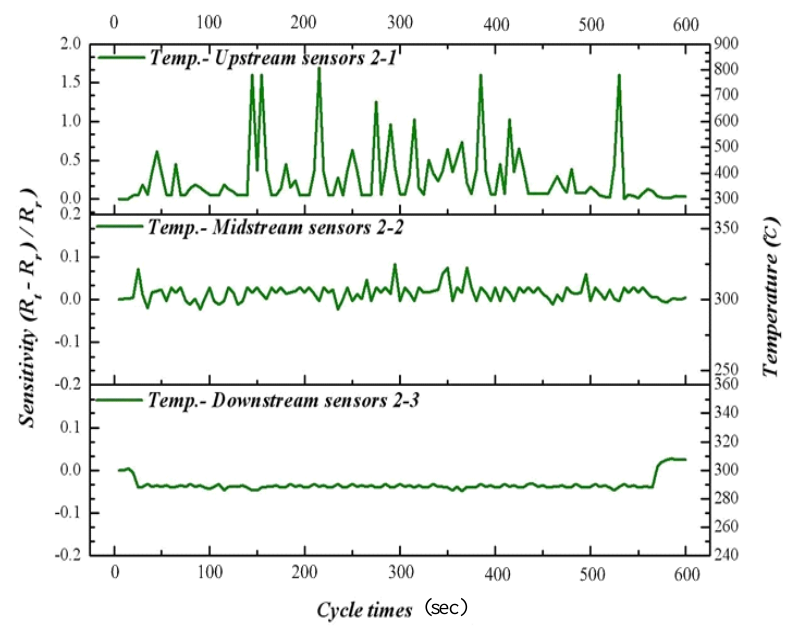
Figure 12. Inner temperature distribution of micro reformer at area 2-1, 2-2, 2-3 (OSRM; 300  C).